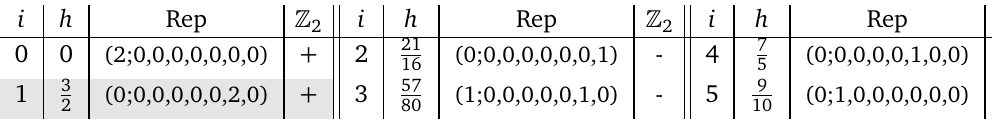
( τ ) . We highlight the primary related to the center symmetry i